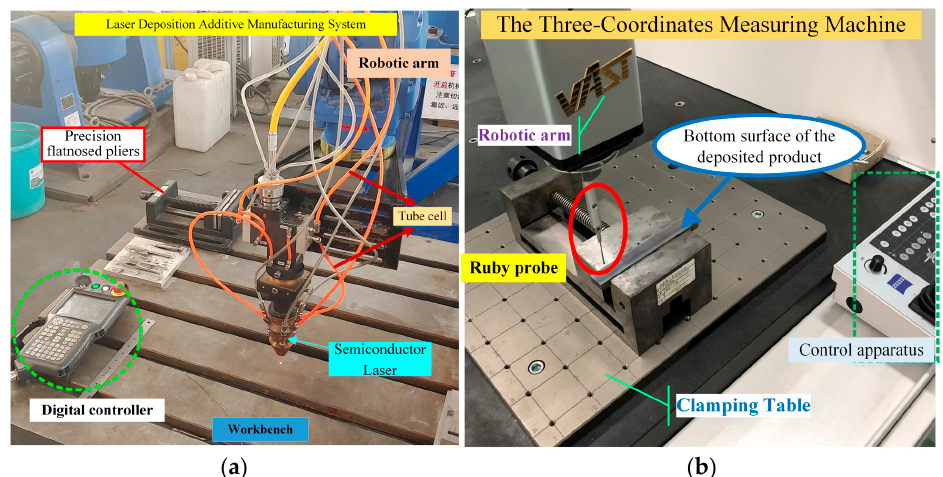
Figure 1. Laser directed energy deposition additive manufacturing and the three-coordinate meas- uring machine: ( a ) laser deposition additive manufacturing system; ( b ) the three-coordinates meas- uring machine.